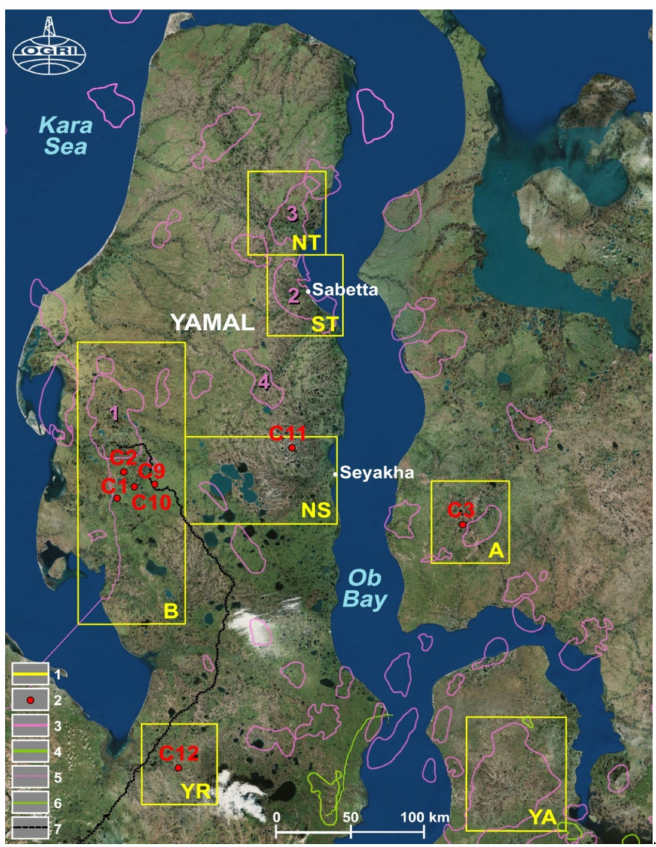
Figure 1. Gas blowout craters on Yamal and Gydan peninsulas. Legend: 1—areas of detailed studies by the Oil and Gas Research Institute of the Russian Academy of Sciences (OGRI RAS) and the Russian Center for Arctic Development (RCAD) (A—Antipayuta, B—Bovanenkovo, ST—South Tambey, NT—North Tambey, NS—Neito-Seyakha, YR—Yerkuta, YA—Yamburg); 2—craters of gas blowouts C1, C2, C3, C9, C10, C11 and C12; 3 and 4—gas, gas condensate (3) and oil (4) fields, including those marked with pink color: Bovanenkovskoye (1), South Tambeyskoye (2), North 7—railroad.